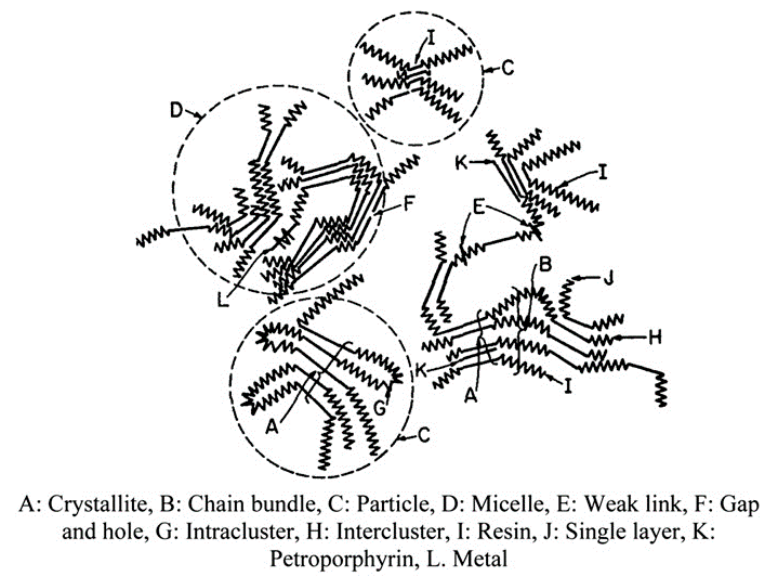
Figure 3. Yen model of solid asphaltenes (reprinted from [28], with permission of the American Chemical Society).